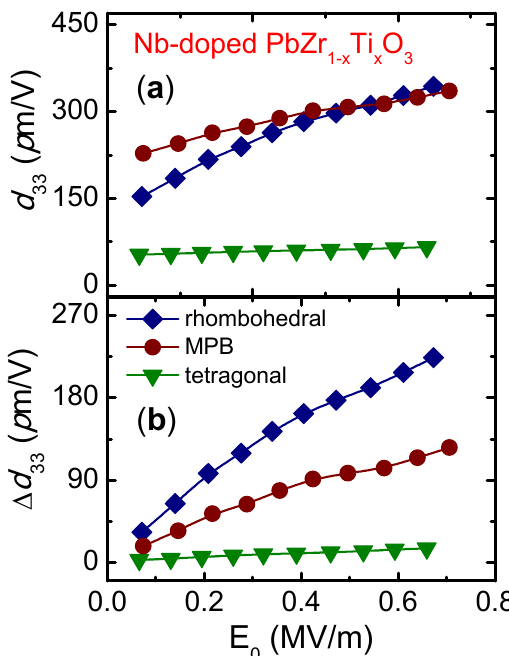
Figure 5. ( a ) Total value and ( b ) increment of the converse piezoelectric coefficient as a function of the applied electric field amplitude for Nb ‐ doped Pb(Zr 1 − x Ti x )O 3 with x = 0.40 (rhombohedral), 0.47 (MPB) and 0.60 (tetragonal). The data were extracted from the reference [26] (Copyright AIP Publishing LCC., 2008).